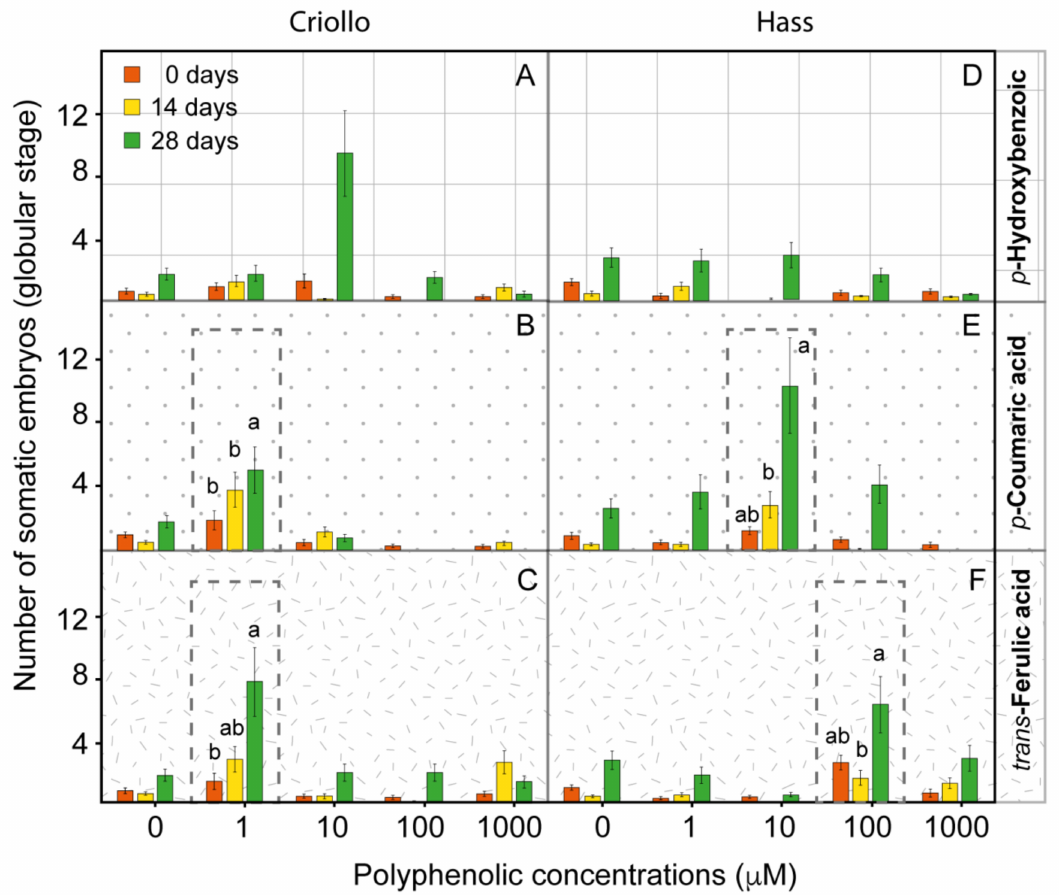
Figure 3. E ff ect of polyphenolics in embryogenic cultures during 28 days of dose-response treatments. TheCriollo( A – C )andHass( D – F )culturesweretreatedwith1, 10, 100, and1,000 µ mof p -hydroxybenzoic acid( A , D ), p -coumaricacid( B , E ),and trans -ferulicacid( C , F ).Thee ff ectofpolyphenolicswasdetermined based on the number of newly formed globular embryos per plate. A general linear model (GLM) was applied with default settings to determine the statistical significance between treatments. Di ff erent letters (a, b and ab) represent a significant di ff erence among treatments ( p < 0.05) marked with dash